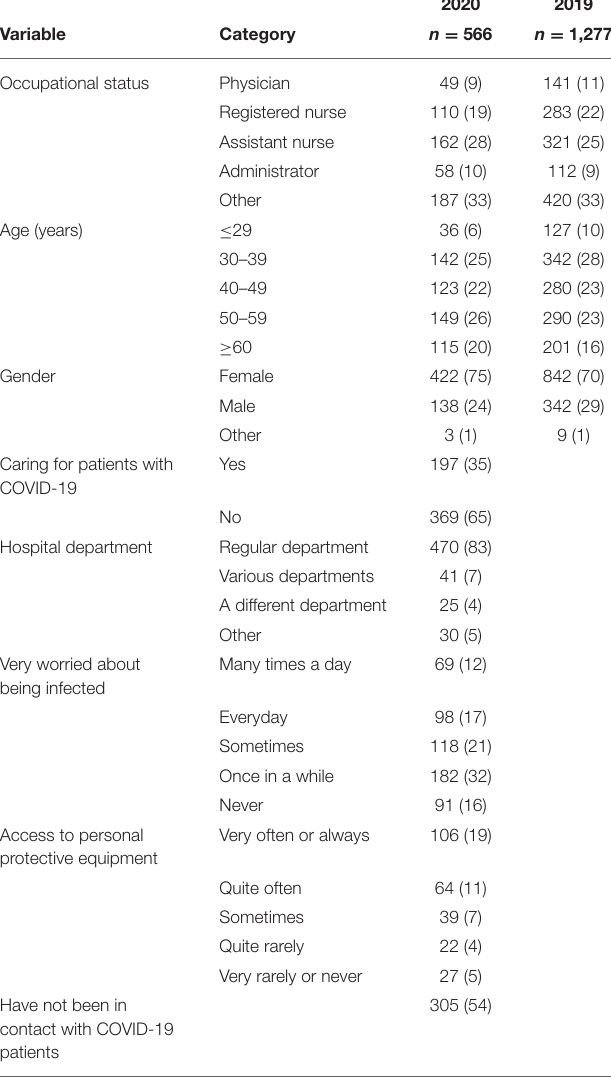
TABLE 1 | Demographics and other characteristics of psychiatric healthcare workers answering a workplace survey in September 2020 and October 2019 [presented as n